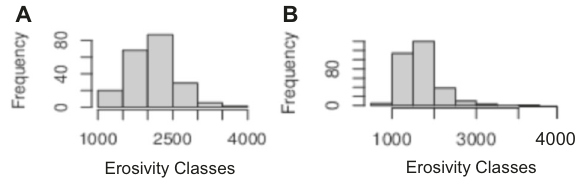
Fig. 6 Comparison of frequency pattern. Frequency distribution of rainfall erosivity for 1500 – 1708 ( A ) and 1709 – 2019 ( B